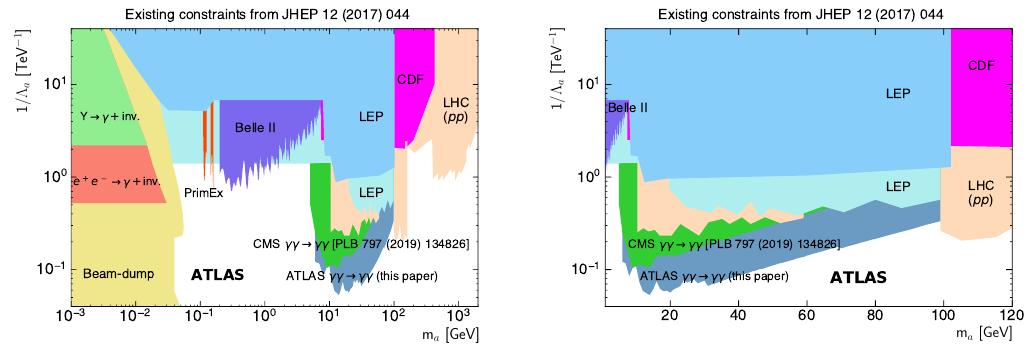
Figure 10 . Compilation of exclusion limits at 95% CL in the ALP-photon coupling ( 1 / Λ a ) versus ALP mass ( m a ) plane obtained by different experiments. The existing limits, derived from refs. [27, 69–72] are compared with the limits extracted from this measurement. The exclusion limits labelled “LHC ( pp )” are based on pp collision data from ATLAS and CMS. All measurements assume a 100% ALP decay branching fraction into photons. The plot on the right is a zoomed-in version covering the range 1 < m a < 120